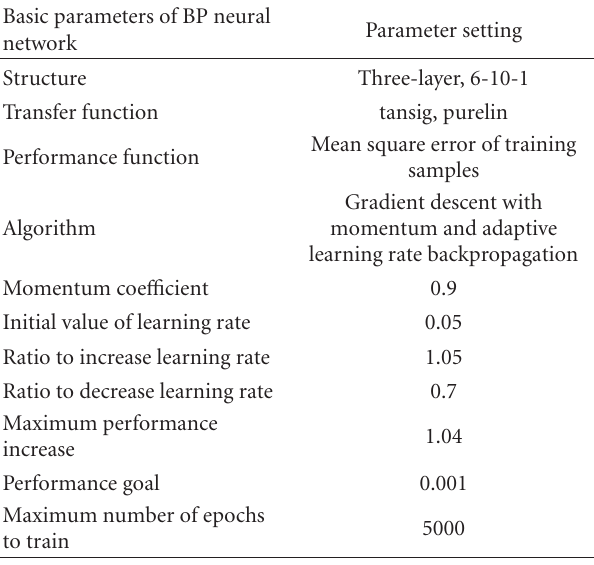
Table 2: The setting of the basic parameters of BP neural network